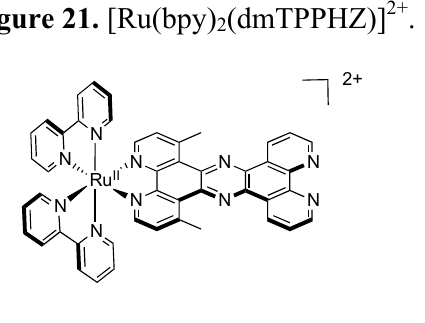
Figure 21. [Ru(bpy)